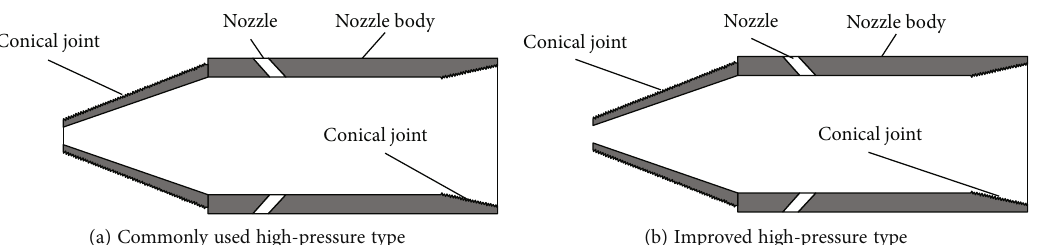
Figure 3: High-pressure type used in punching tests.